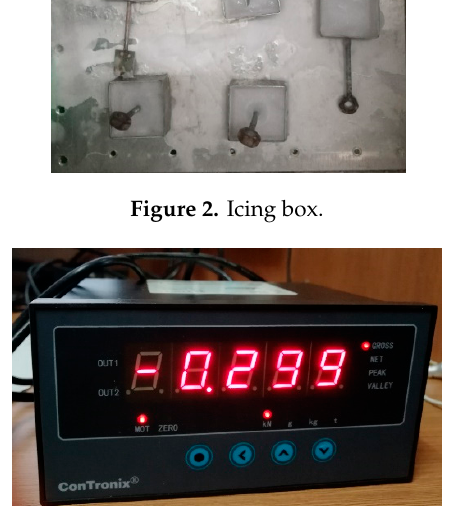
Figure 3. Tension sensor.